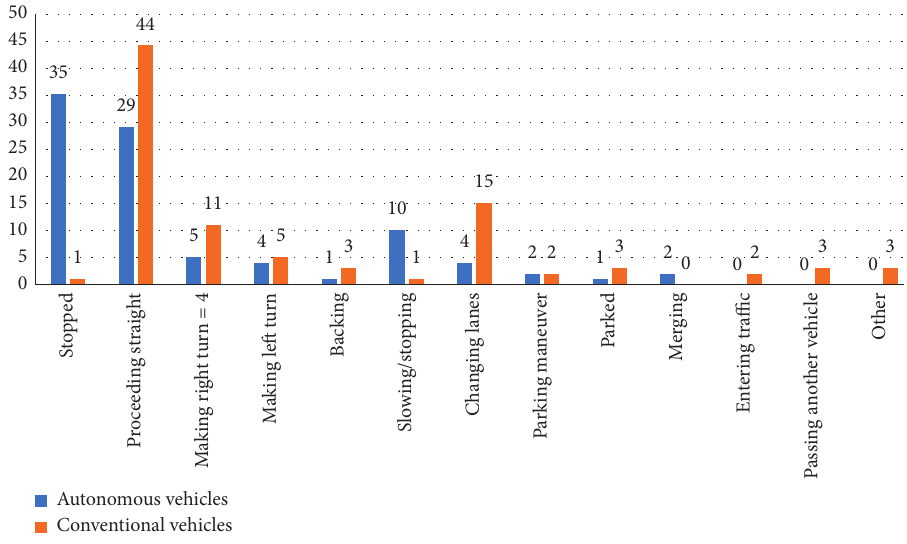
Figure 3: Movement preceding collision.